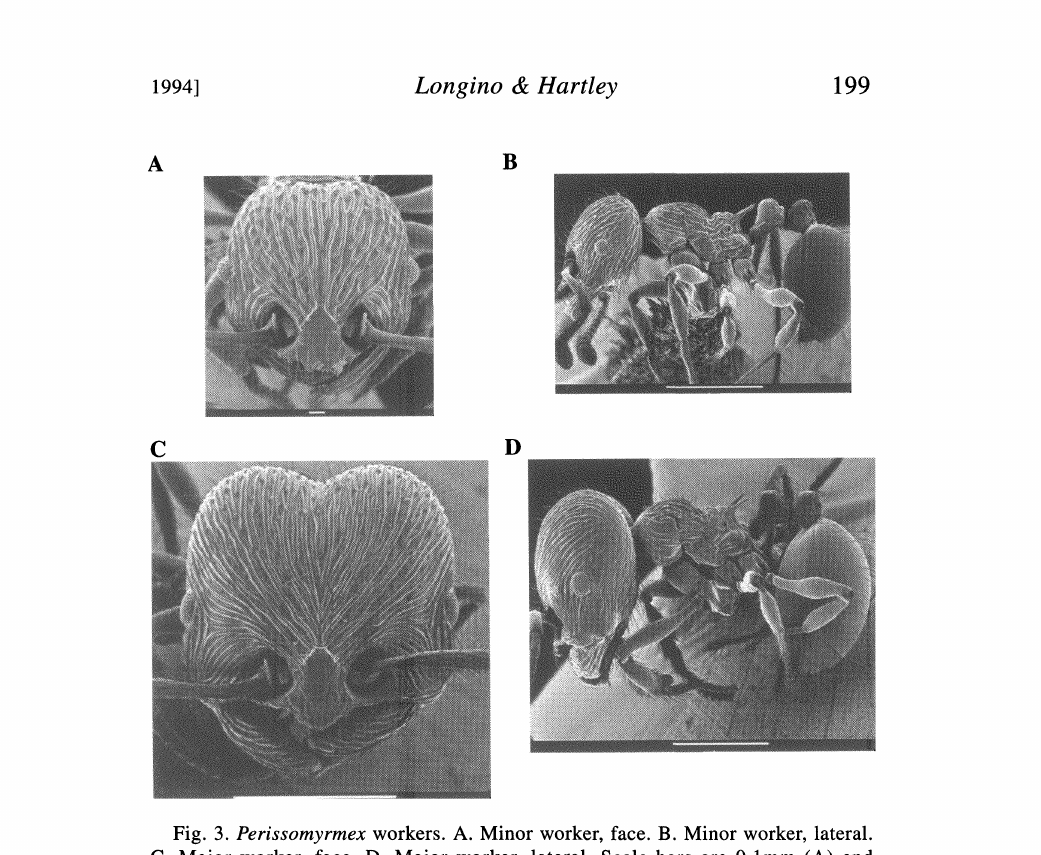
Fig. 3. Perissomyrmex workers. A. Minor worker, face. B. Minor worker, lateral. C. Major worker, face. D. Major worker, lateral. Scale bars are 0.1mm (A) and 1.0mm (B,C,D). Face views are to same scale, and lateral views are to same